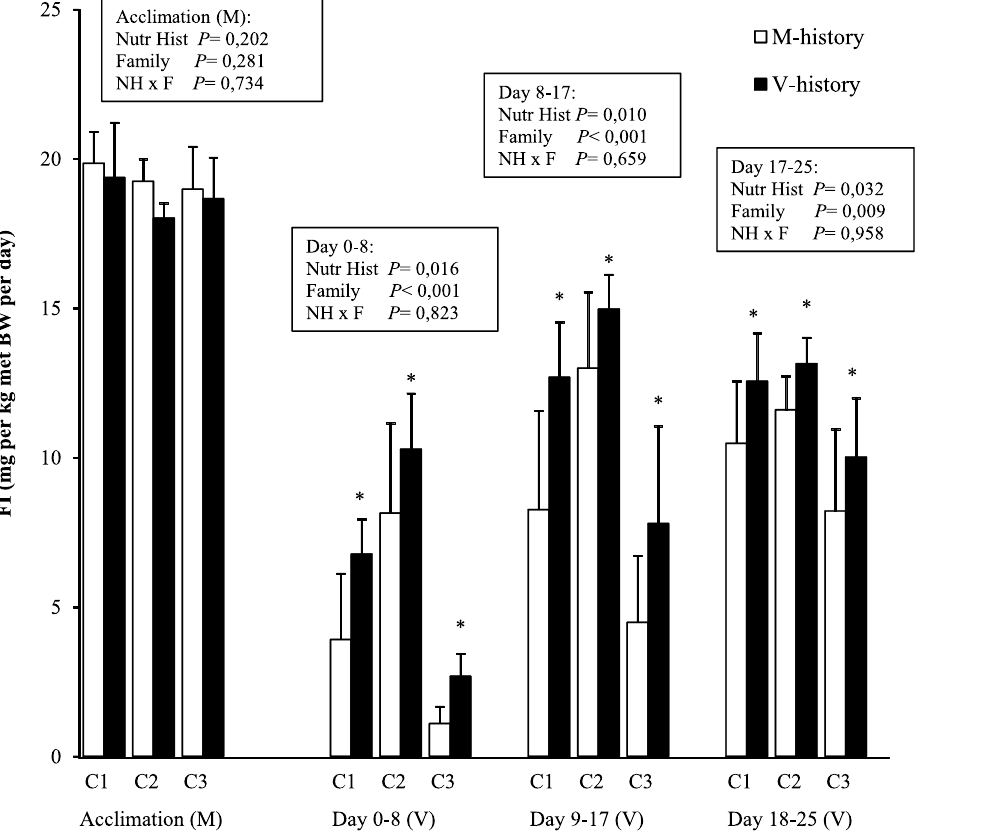
Table 2. The body weight (BW) of the trout at the start of the V-challenge and body composition of the fish at the start and at the end of the V-challenge.